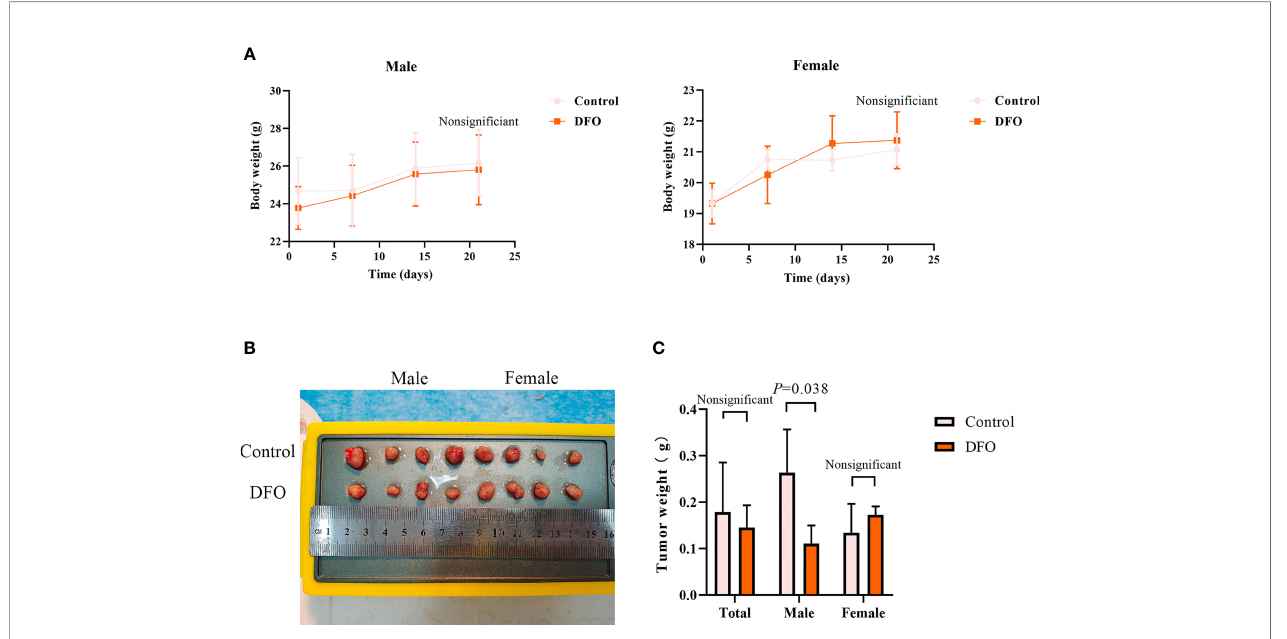
FIGURE 7 | DFO inhibits cisplatin-resistant lung adenocarcinoma tumor growth. (A) Body growth curves of mice injected subcutaneously with A549/DDP cells and treated with DFO (8 mg/kg, 2 doses/week for 3 weeks). (B) The overall scope of tumors of mice injected subcutaneously with A549/DDP cells and treated with DFO (8 mg/kg, 2 doses/week for 3 weeks). (C) Tumor weight of mice injected subcutaneously with A549/DDP cells and treated with DFO (8 mg/kg, 2 doses/week for 3